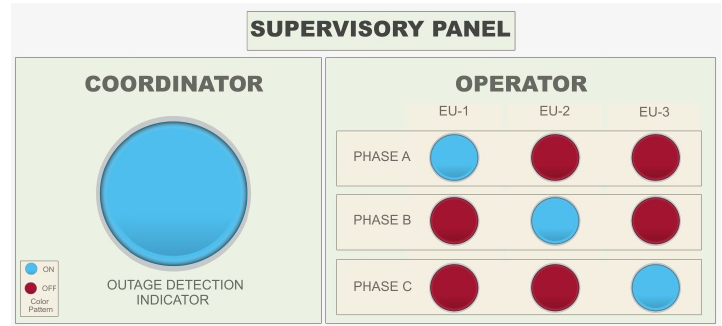
Figure 20. Presentation screen of the data concerning the result of the execution of the assay procedures (test algorithm) of the Phase Unbalance Correction